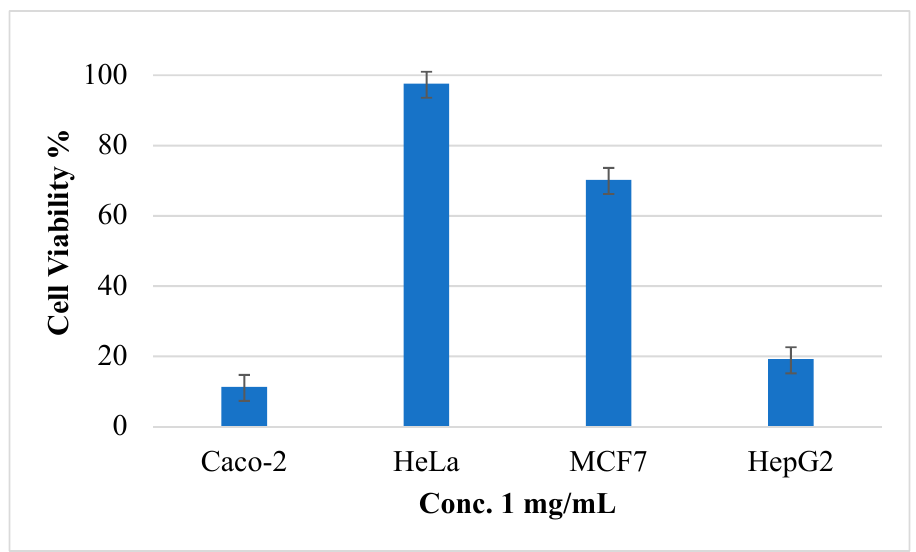
Figure 6. The cell viability percentage of Artemisia jordanica essential oil against four cancer cell lines at 1 mg/mL concentration ± SD.